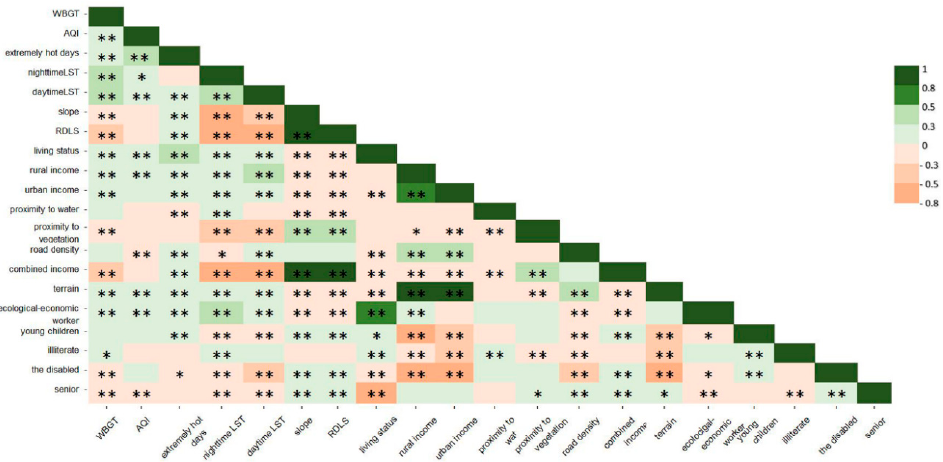
Figure A1. Spearman’s rho nonparametric correlations and significances among the selected variables used in spatial analysis (significance levels: **. Correlation is significant at the 0.01 level (2-tailed). *. Correlation is significant at the 0.05 level (2-tailed).).